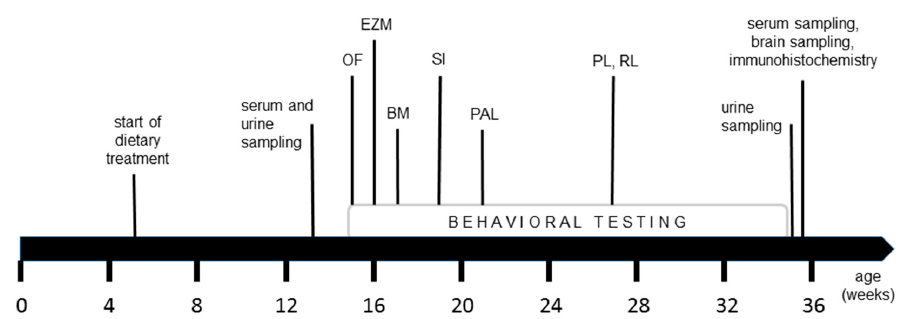
Figure 2. Time line of the study course; open field test (OF), elevated zero maze (EZM), Barnes maze (BM), social interaction test (SI), touchscreen paired associates learning (PAL) inclusive